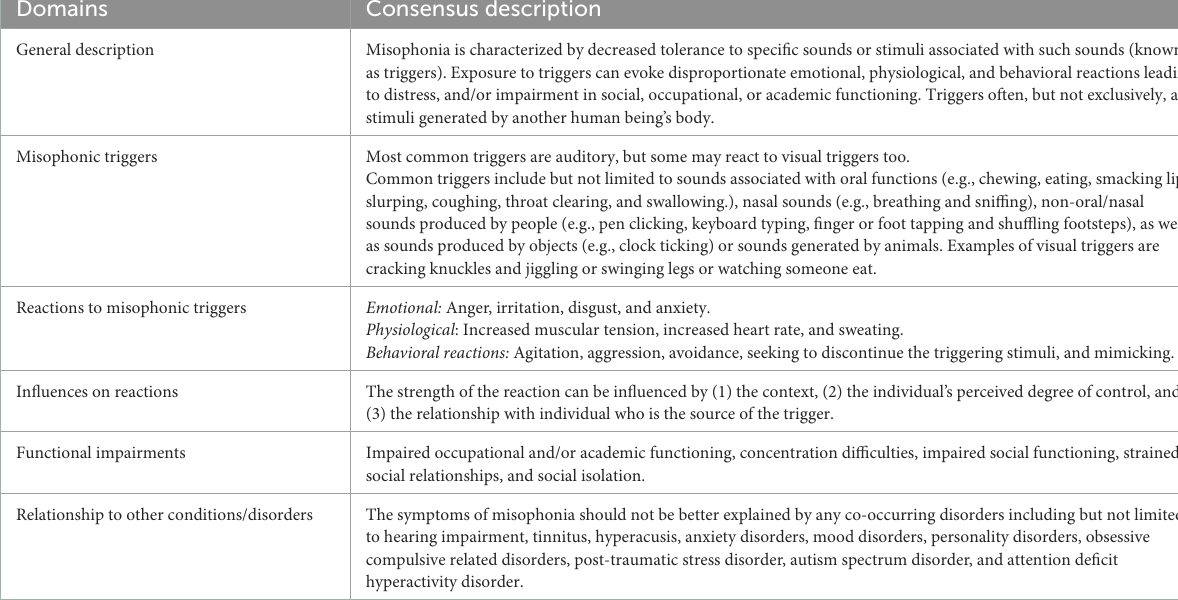
TABLE 1 Summary of the consensus definition of